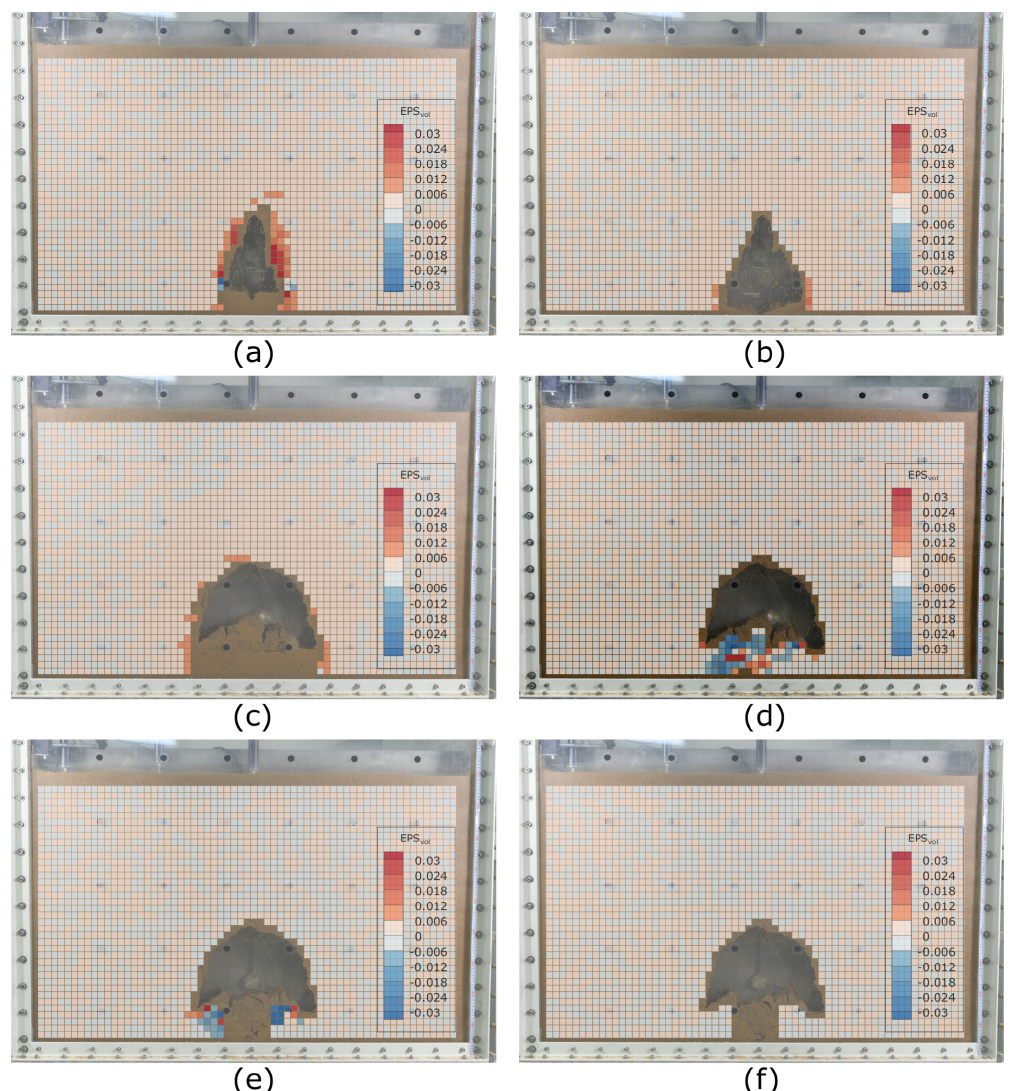
Figure 5. Volumetric strain inside the model ground for Test 1 during the water drainage stage: (a) 0–30s, (b) 30–60s, (c) 60–90s, (d) 90– 120s, (e) 120–150s, and (f)